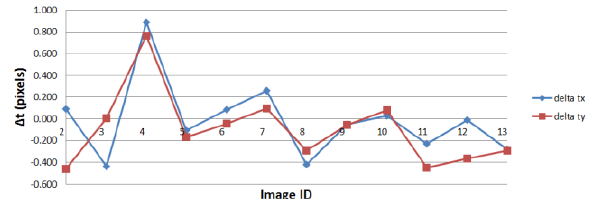
Figure 5. Comparison between results of image registration based on manual and automated measurements.